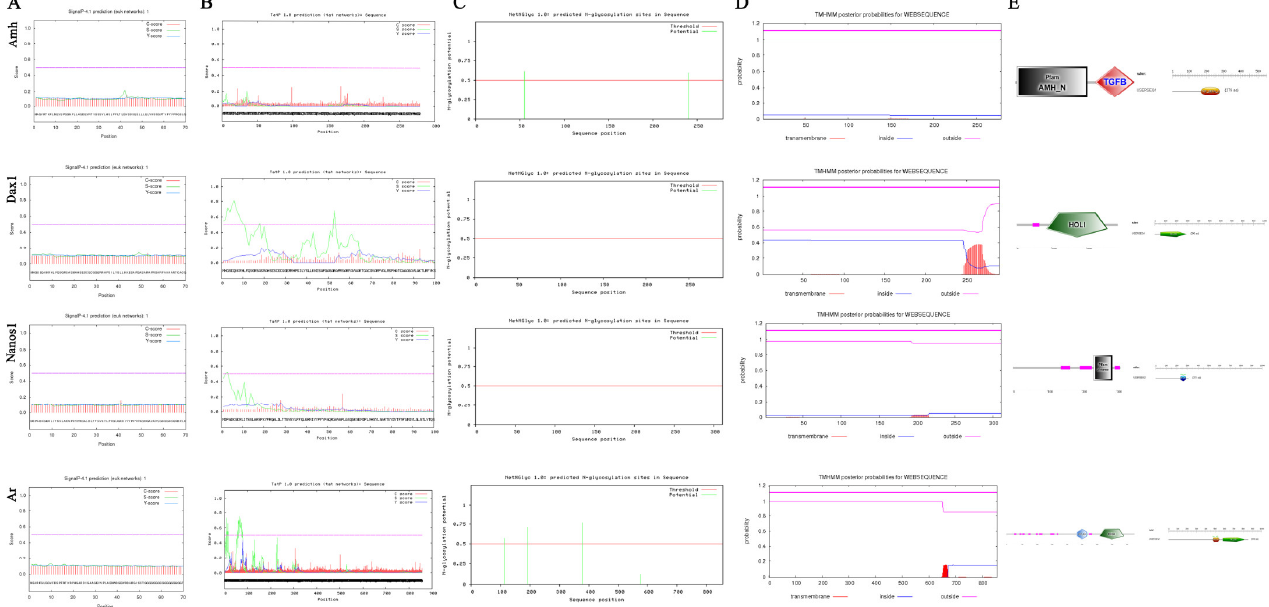
Figure 4. Sequence characterization of AMH, DAX1, NANOS1, and AR. ( A ): shear site; ( B ): signal peptide; ( C ): glycosylation sites; ( D ): transmembrane structural domains; ( E ): functional domain prediction.